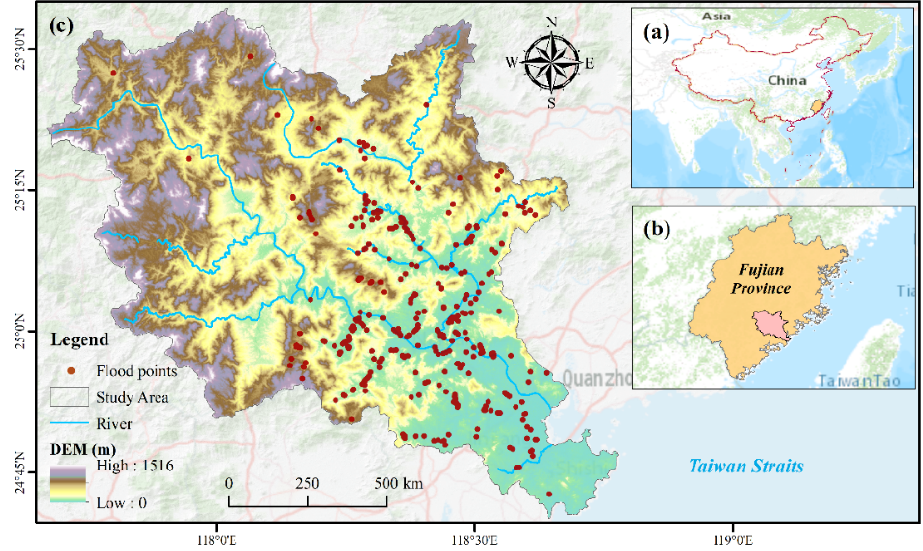
Figure 1. The study area of Jinjiang Basin: ( a ) Fujian province in China; ( b ) Jinjiang Basin in Fujian province; ( c ) digital elevation model (DEM), and location of the main river in Jinjiang Basin.